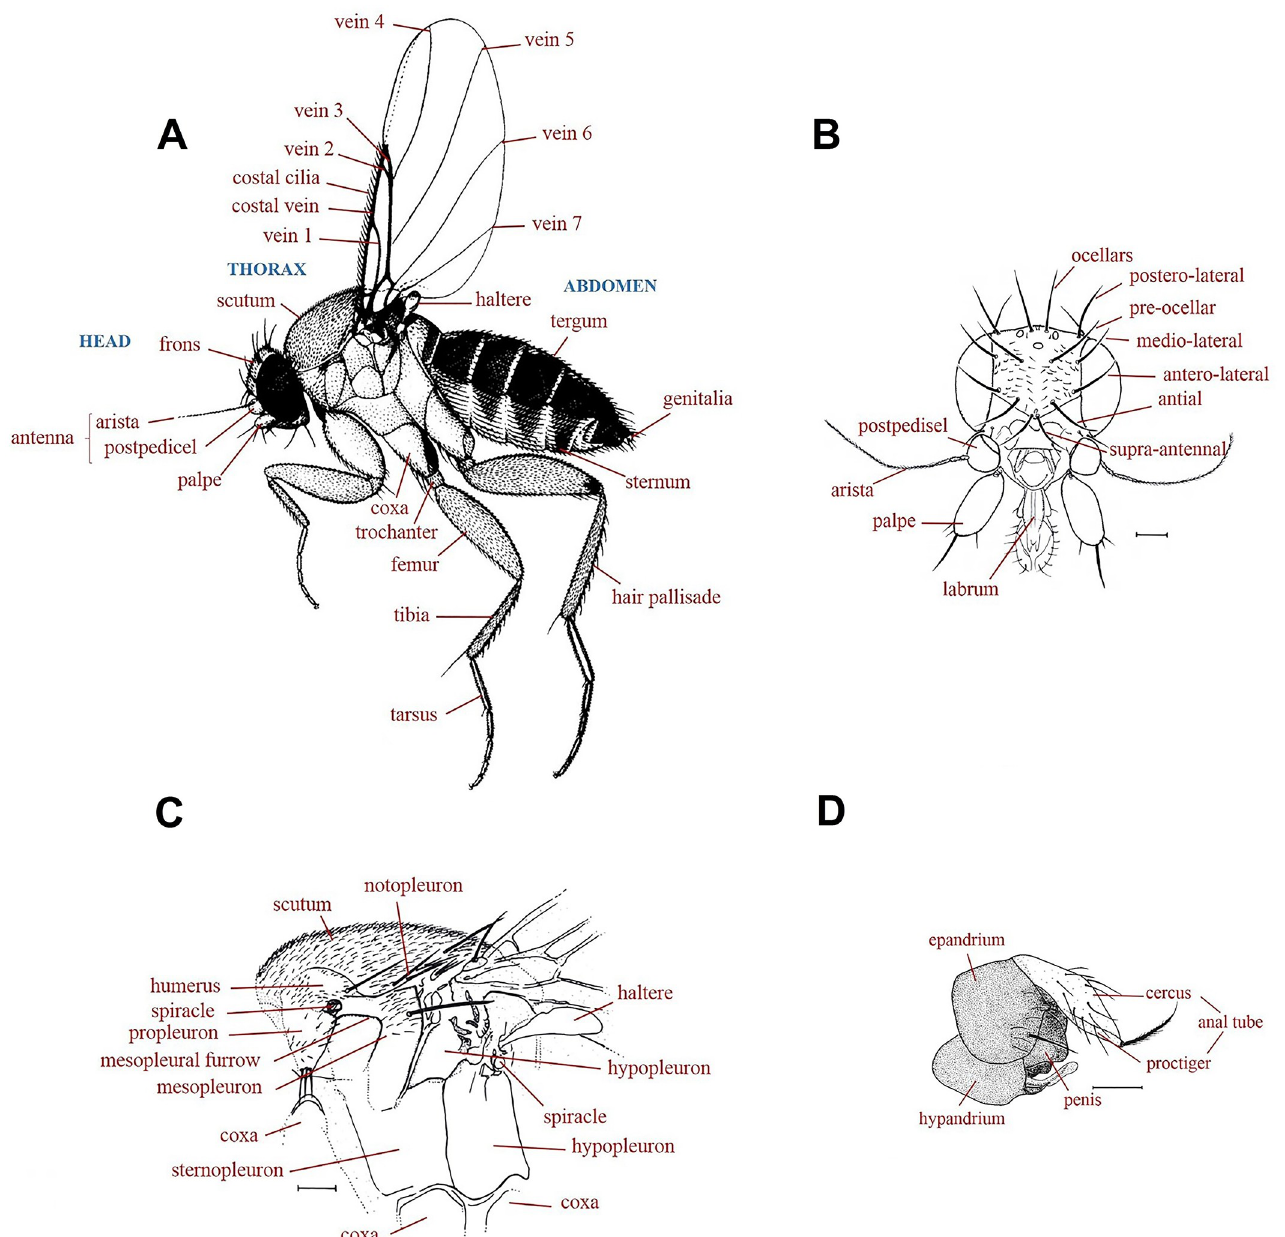
Fig 7. Characters of adult male phorid flies used in the key. A, Lateral view of whole fly ( Megaselia scalaris ); B, frontal view of head ( Triphleba nudipalpis ), showing bristles; C, left side of thorax ( Megaselia ciliata ); D, left side view of male hypopygium ( Megaselia scalaris ). Modified from Smith, 1986.